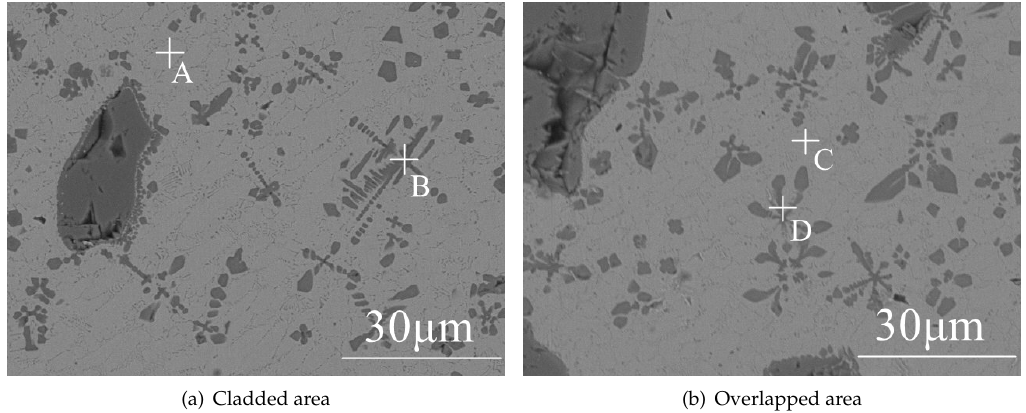
Figure 12. Microstructure of cladding layer.